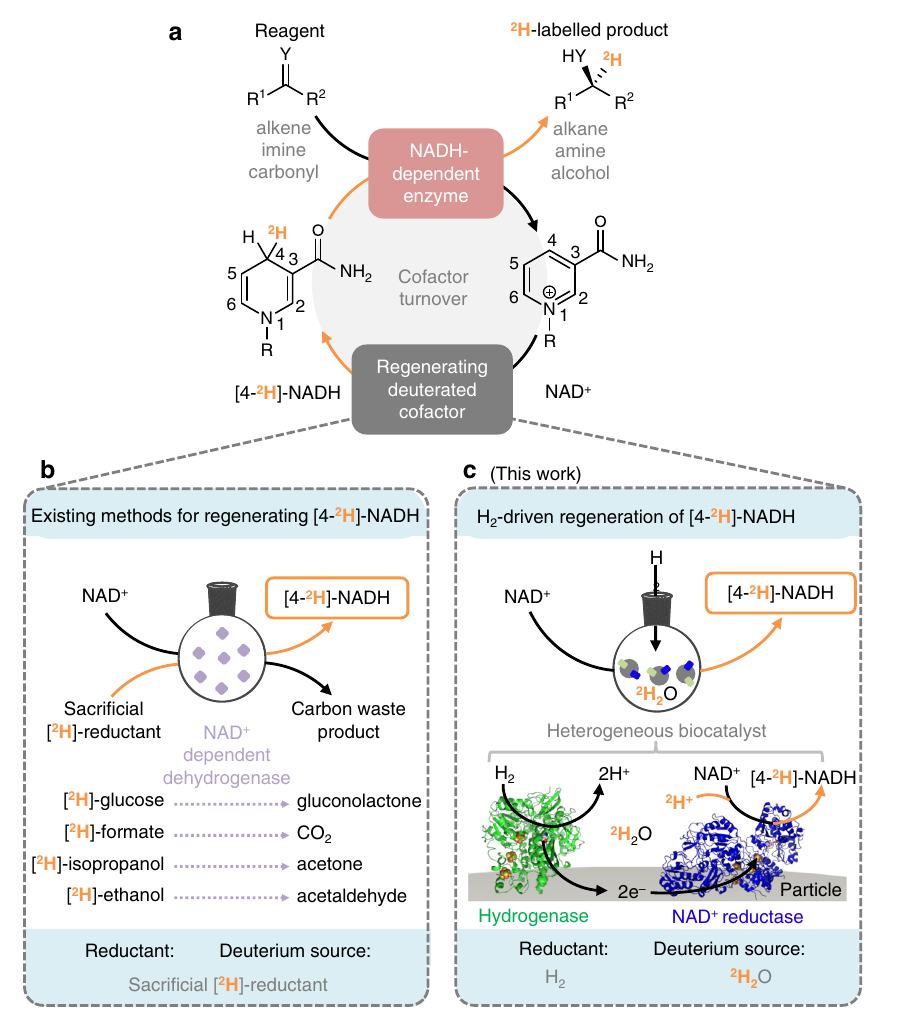
Fig. 2 Biocatalytic reductive deuteration via recycling of [4- 2 H]-NADH. a Biocatalytic reductive deuteration requires a supply of [4- 2 H]-NADH. b Conventional [4- 2 H]-NADH-recycling strategies are driven by a sacri fi cial deuterated reductant. c Schematic representation of the heterogeneous biocatalytic system demonstrated in this work for H 2 -driven generation of the labelled cofactor [4- 2 H]-NADH, with 2 H 2 O supplying the deuterium atoms. For complete structures of the cofactors, see Supplementary Fig. 1 and for details of the heterogeneous biocatalyst, see Supplementary